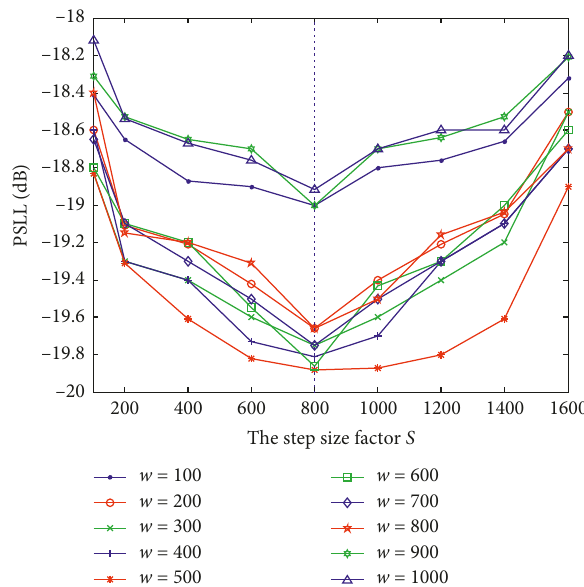
Figure 7: Effect of parameters S and ω on the optimization of Example 1.